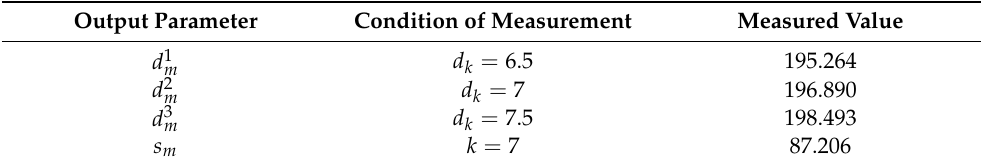
Table 5. Measurements of the selected gear.